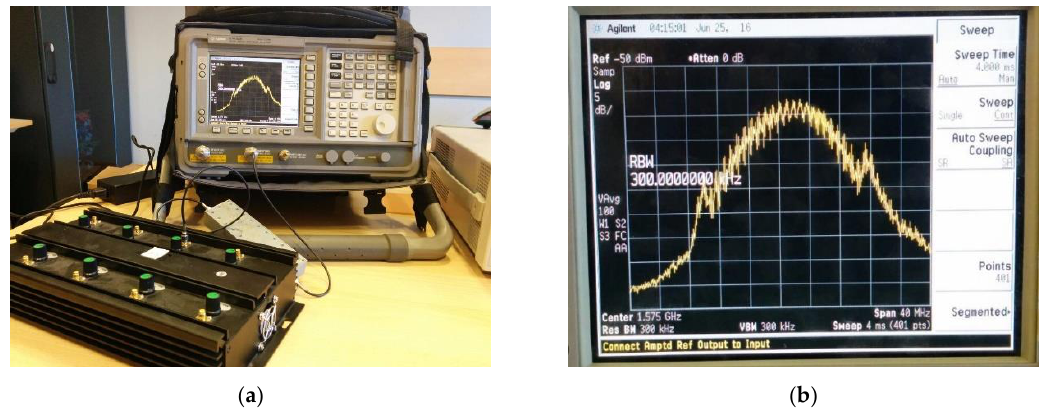
Figure 4. Spectral analysis of the jammer on the L1 band ( a ) and zoomed-view ( b ).